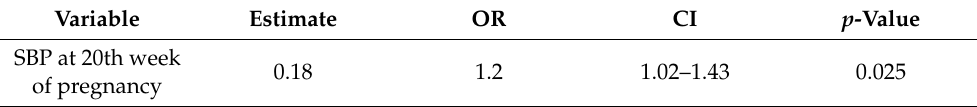
Table 3. Logistic regression results for predicting PE. OR—odds ratio, CI—confidence